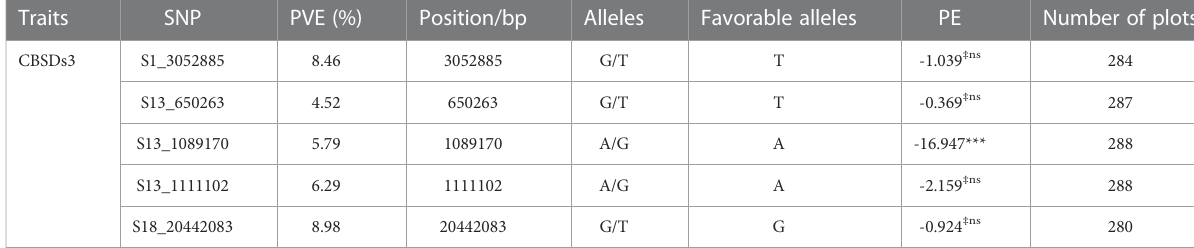
TABLE 6 Proportion of variance explained (PVE), favorable SNP alleles and their phenotypic effects (PE). Traits SNP PVE (%) Position/bp Alleles Favorable alleles PE Number of plots